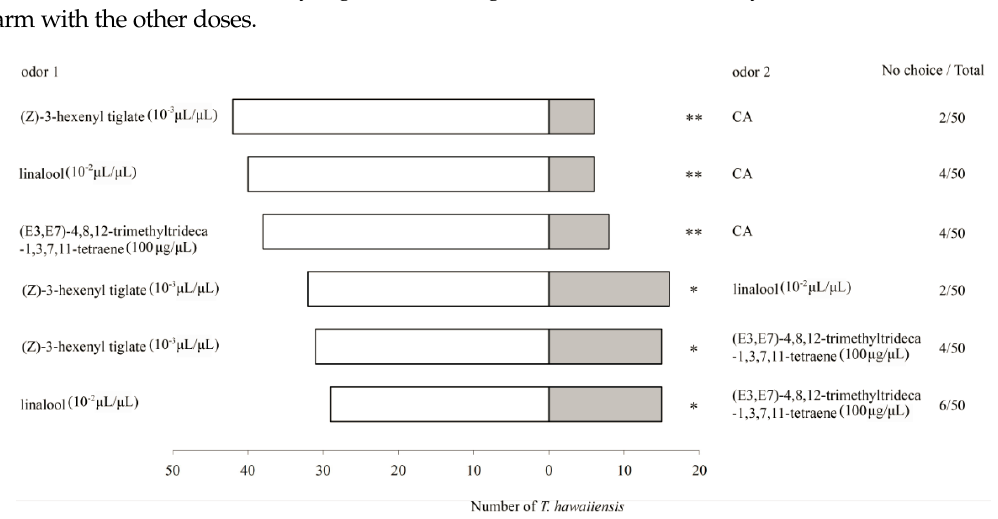
Figure 3. Behavioral responses of T. hawaiiensis to the main Ga. jasminoides volatiles. Asterisks indicate highly significant (** p < 0.01) and significant (* p < 0.05) differences in the selectivity of T. hawaiiensis between two odors by χ 2